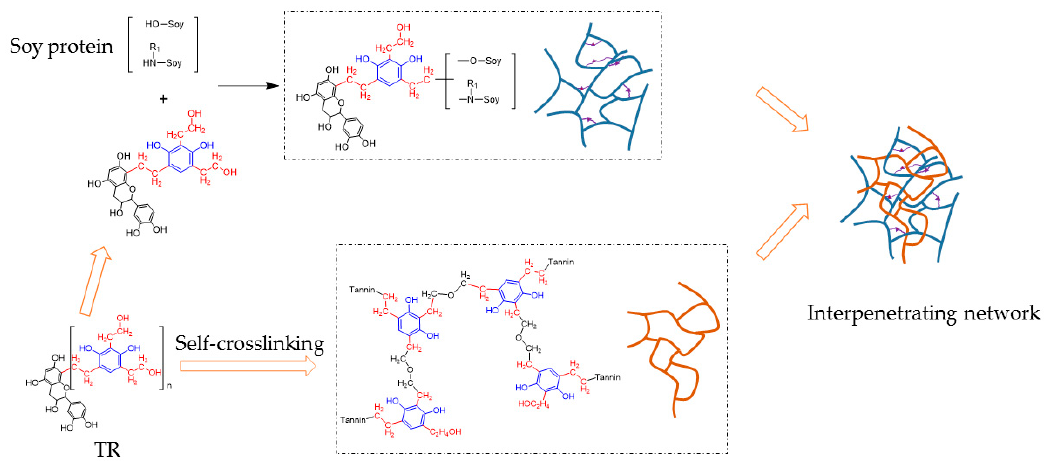
Scheme 2. The reaction of TR/SPI.